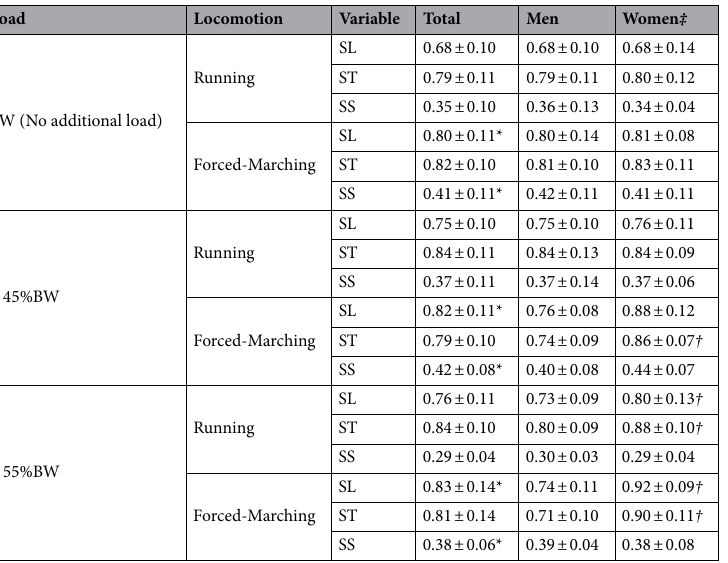
Table 6. Spatiotemporal Alpha Coefficients (Complexity). mean ± standard deviation. SL = Stride Length; ST = Stride Time; SS = Stride Speed. BW = Body weight (No additional load); + 45%BW = Plus an additional 45% of BW; + 55%BW = Plus an additional 55% of BW. α = .5 represents stochastic (white noise); α < 0.5 represents anti-persistence; 0.75 < α < 1.3 represents persistent behavior (optimal complexity); α = 1 equal persistent behavior exhibiting power law scaling (pink noise); α ≥ 1.5 represents over regularity (brown noise). *Significantly greater than running. †Significantly greater than men; ‡Significant simple main effect of load for SL and SS (complexity increasing with